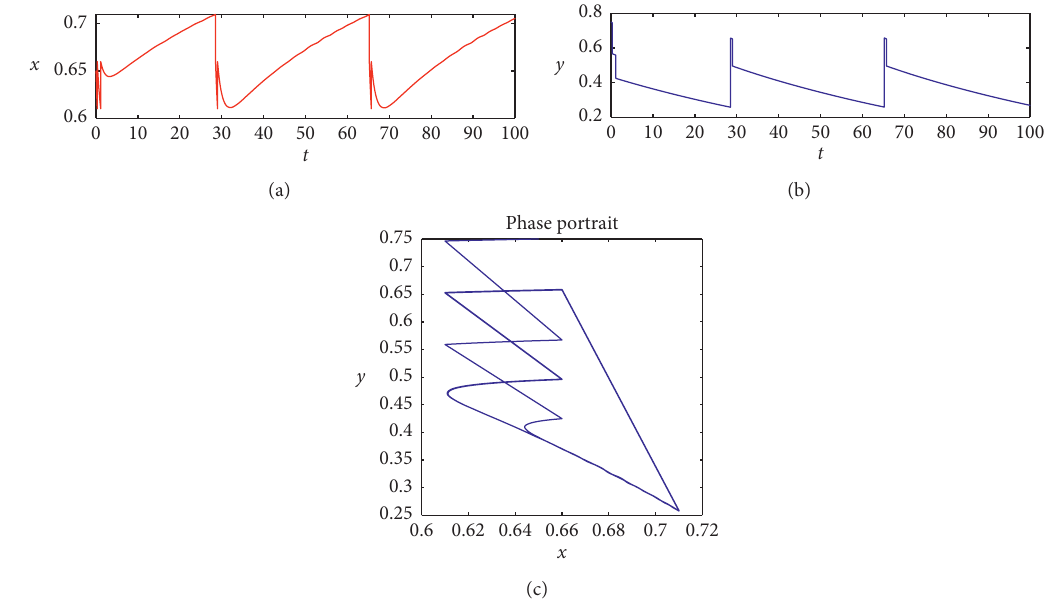
Figure 10: The order-2 periodic orbit of system (12). Control parameters: p � 0.6 and τ �